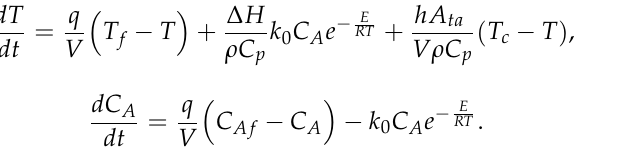
Table 1. The considered nominal values for the parameters of the CSTR plant.